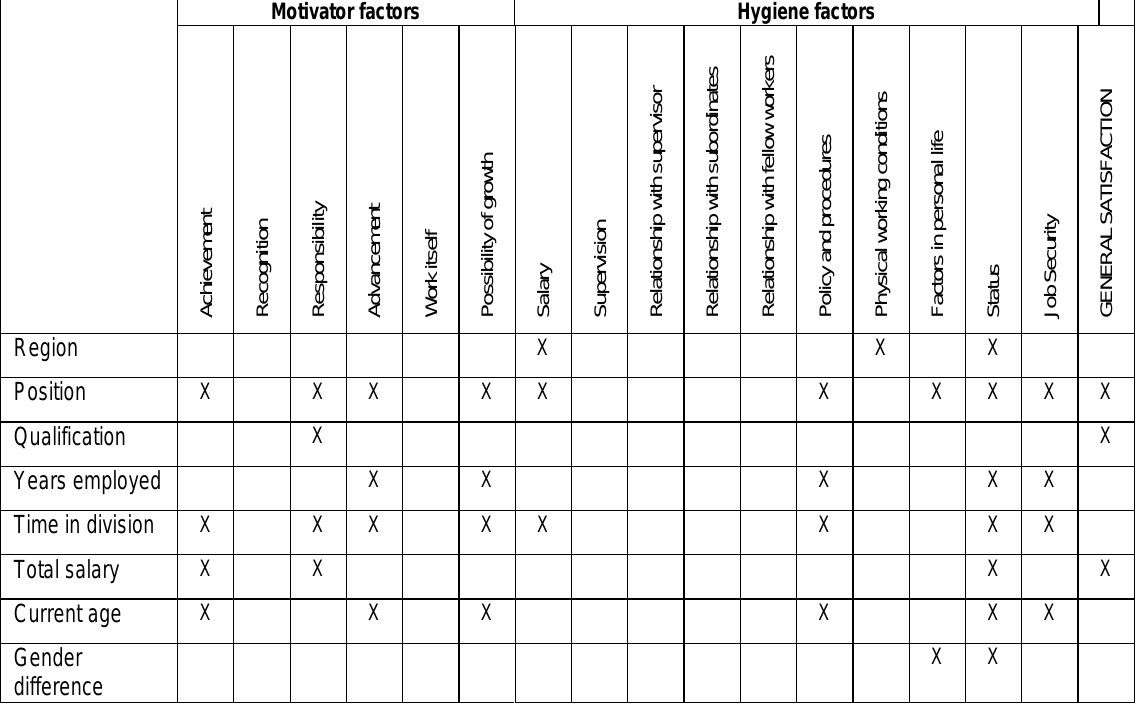
Table 1 Significant motivational profile differences Motivator factors Hygiene